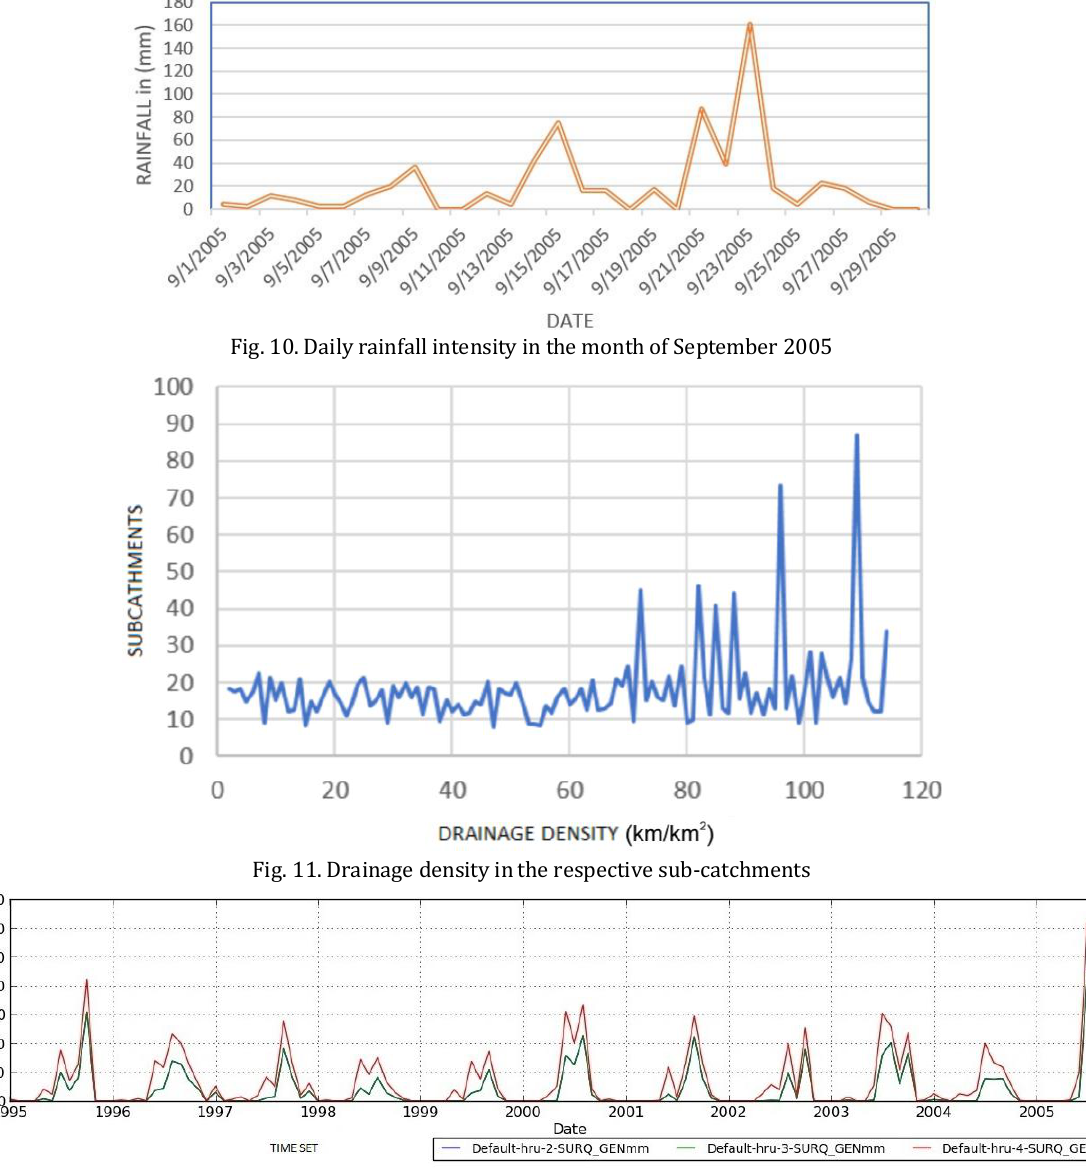
Fig. 12. Surface runoff generated in sub catchment 4 during time